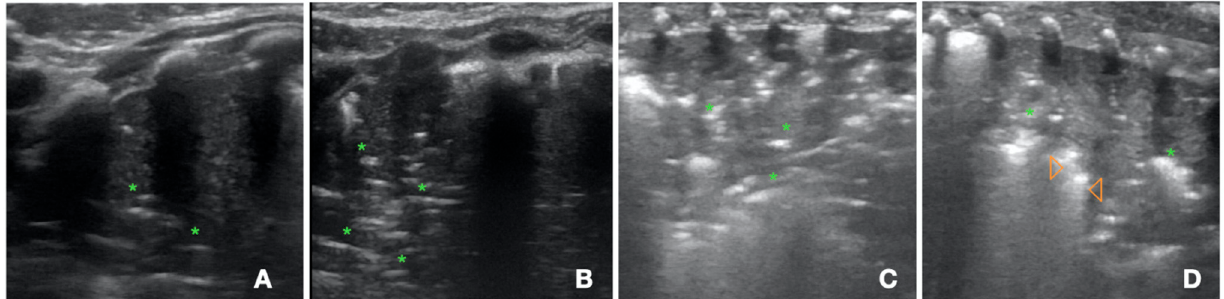
Figure 3. Dead-space (D)-pattern versus sunray (S)-pattern. ( A ) C-pattern with air bronchogram (green asterisks). ( B ) In this patient, the increase in continuous distending pressure (CDP) resulted in a more pronounced air bronchogram (green asterisks), suggesting an increase in dead space recruitment without any sign of alveolar recruitment (D-pattern). The D-pattern suggests a non-recruitable lung. ( C ) C-pattern with air bronchogram (green asterisks) ( D ) S-lines (orange arrowheads) develop from the reopening bronchi at the CDP increase, creating the S-pattern, that suggests lung